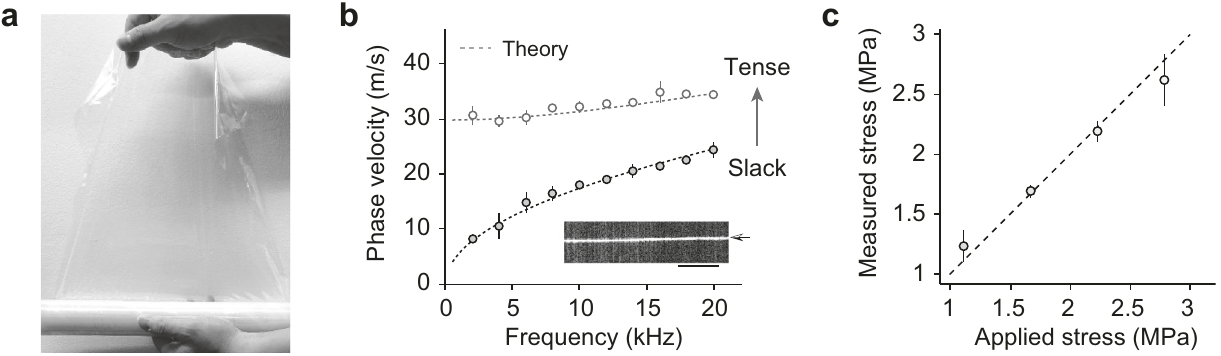
Fig. 2 Measuring the stress in cling fi lm. a Photograph of the cling fi lm. Scale bar, 10 cm. b Dispersion curves for a cling fi lm, in the stress-free (lower) and stressed (upper) states. Markers, experiment. Curves, theory. Inset, Optical Coherence Tomography (OCT) transverse image of the cling fi lm, which is too thin for an accurate thickness measurement by OCT. Scale bar, 0.5 mm. c Comparison between the applied and identi fi ed stress. Dashed line, 45 ∘ line for reference. Error bars are the standard deviations from fi ve